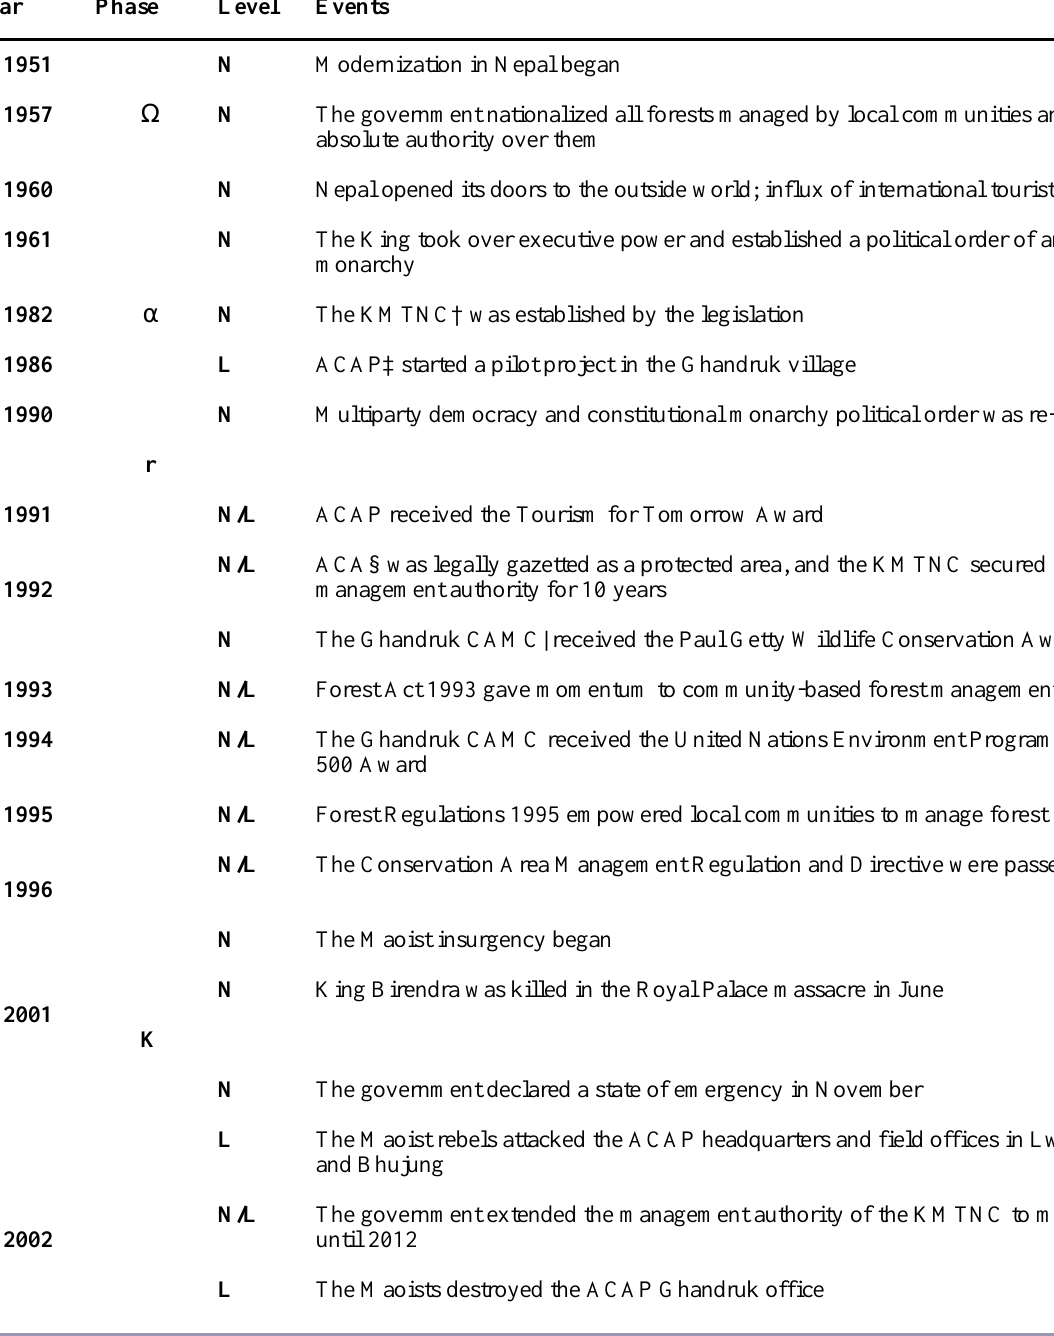
Table 1 . Historical profile of the Annapurna region summarizing major events that occurred at the national (N) and local (L) levels from 1951 to 2008. The four phases of the adaptive cycle are shown: exploitation (growth) = r, conservation (maturation) = K, release (collapse) = W , and reorganization = a . The phases of the adaptive cycle are applicable to the Annapurna region only, not to the national